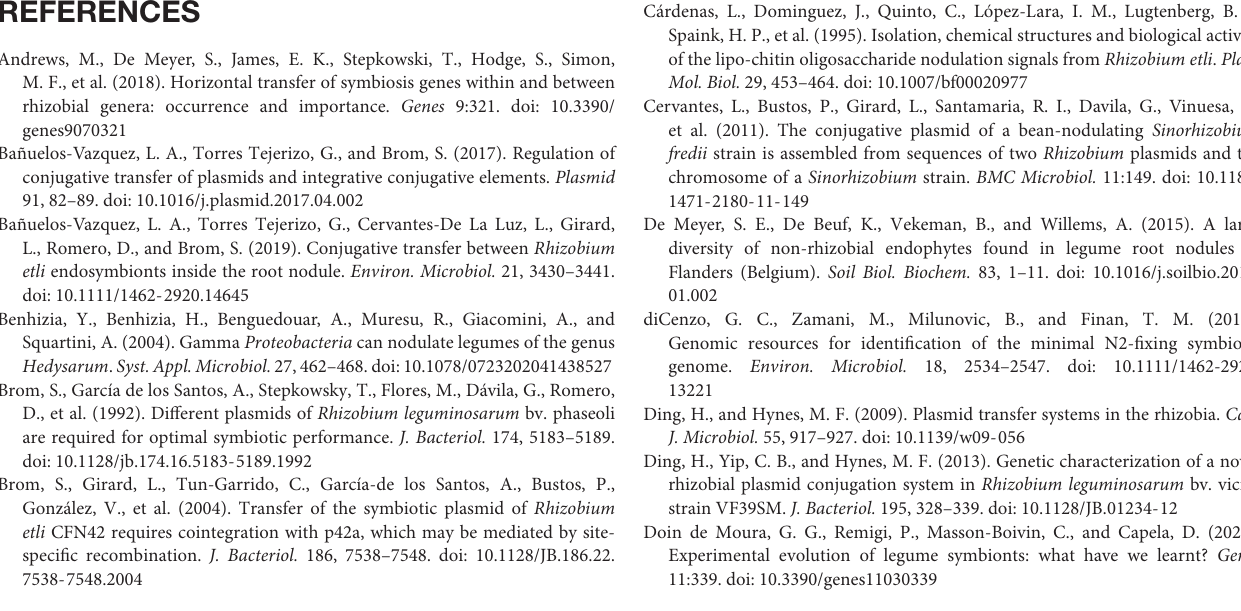
FIGURE S1 | PCR amplifications of R. etli pSym markers in the TER strains. To determine the presence of markers of the R. etli pSym in the putative transconjugants of endophytic recipients, DNA was isolated from the different strains and used as template to produce PCR products for nodD1 (A) , nodA (B) , fixNd (C) , nifH (D), and GFP (E) , from the pSym of R. etli CFNX182-1. The lane labeled 182-1 corresponds to strain CFNX182-1, MWM – molecular weight markers. FIGURE S2 | Maximum-likelihood tree of 16S rRNA gene of the TER isolates from nodules of Phaseolus vulgaris . The tree shows the phylogenetic association of TER isolates with strains of different genera (reference type strains) belonging to Proteobacteria and Firmicutes phyla from according to their 16S rRNA gene sequences. The tree was built under the GTR model and rooted at the midpoint. The bar indicates the number of expected substitutions per site under this model. The bootstrap support value (100 replicates) of the branches of tree is shown in each node. FIGURE S3 | Stability of pSym-associated antibiotic resistance markers in TER strains. The different TER strains were inoculated into antibiotic-free media, and samples were taken at inoculation (T 0 ) and after 72 h of incubation (T72), to determine the loss of antibiotic resistance, by quantifying the populations in the presence and absence of antibiotic. Each strain was compared to the control strain CFNX182-1. (A) TER31, (B) TER38, and (C) TER49. CFNX182-1 with antibiotic (black bars), CFNX182-1 without antibiotic (gray bars), TER strains without antibiotic (white bars), TER strains with antibiotic (striped